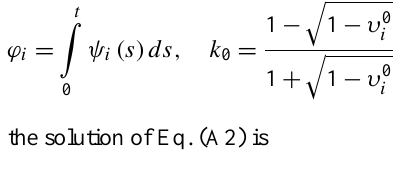
and υ l for the following set i i = 1, a i = i , i = 0 . 002 and supposing that h i (t) has 1 m 3 · s